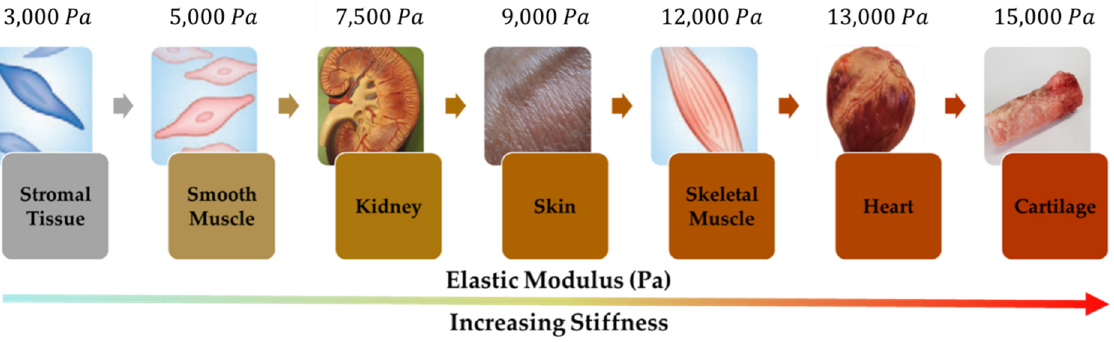
Figure 10. The finite element model of MRTGC with the handgrip: ( a ) 3D model of meshed MRTHC, ( b ) cross-section of normal force generated when hand deformation occurs in MRTGC section . Table 2. The simulated value of stiffness of MRTGC.